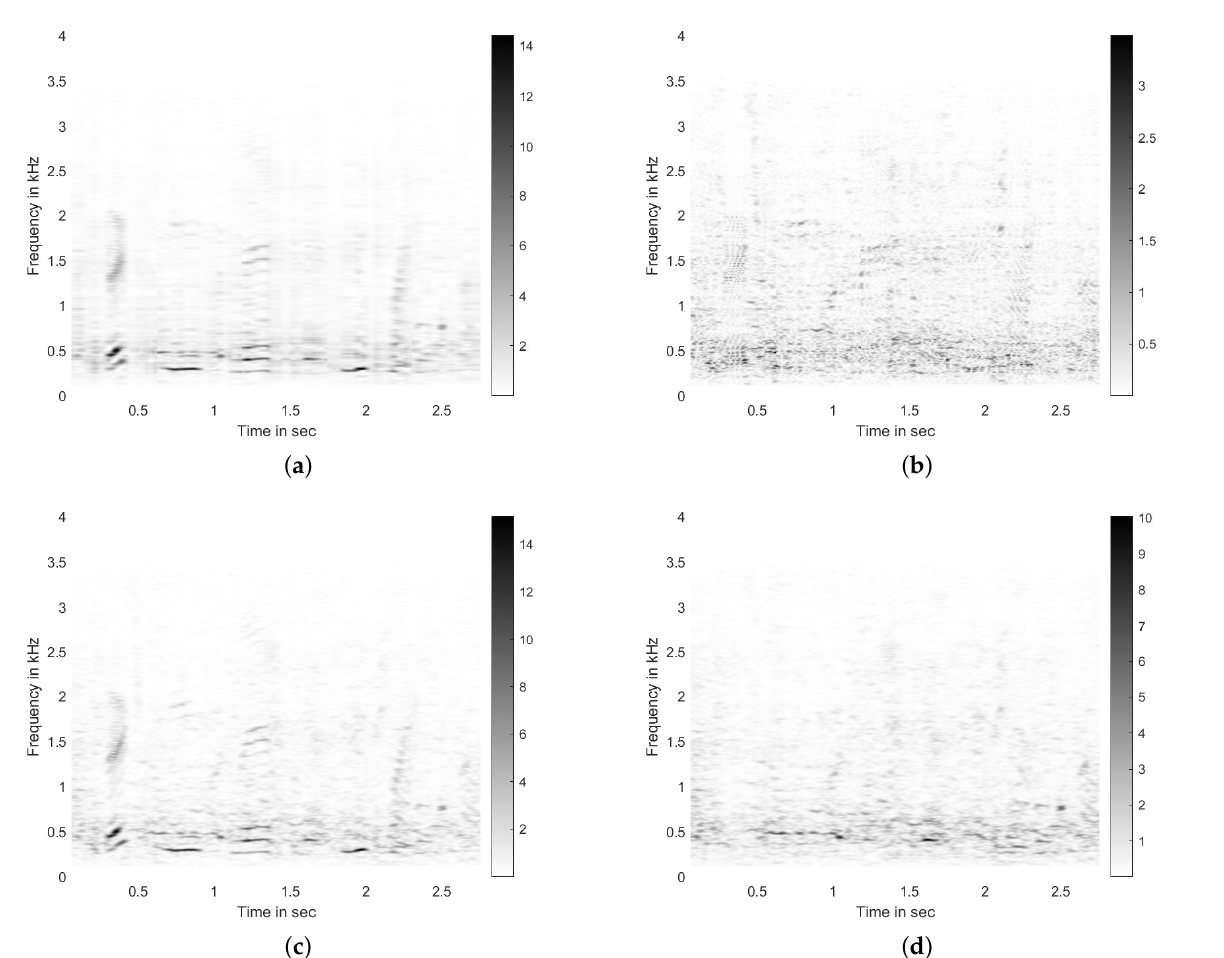
Figure 6. The approximated STFT ˆ X of noisy STFT ( a ) and the residual ( ˆ X − X ) ( b ). For comparison, the noisy STFT X = Y and noise-only STFT from Figure 1 are reproduced in ( c , d ),